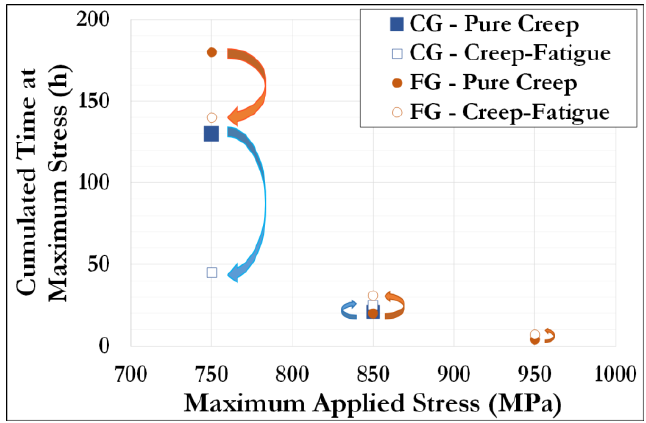
Figure 13. Comparison of pure creep and dwell-fatigue (10 s hold times) time to failure for both microstructures at 700